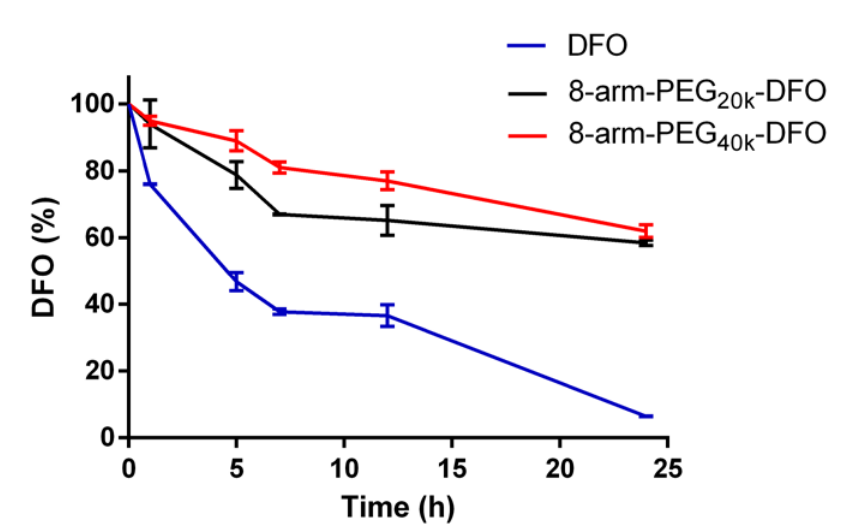
Figure 4. The stability of free DFO, 8-arm-PEG 20k -DFO, and 8-arm-PEG 40k -DFO conjugates in plasma.